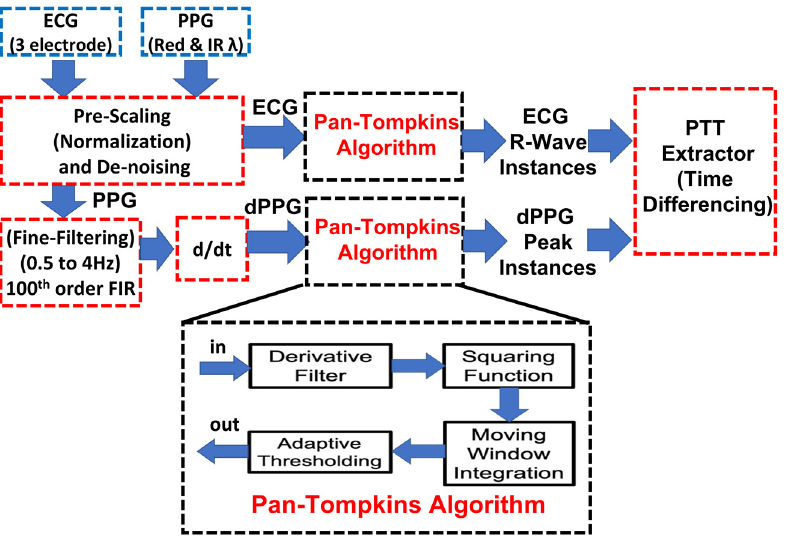
Figure 5. Pulse transit time (PTT) extraction methodology incorporating Pan–Tompkins algorithm for R ‐ wave and dPPG peak detections.